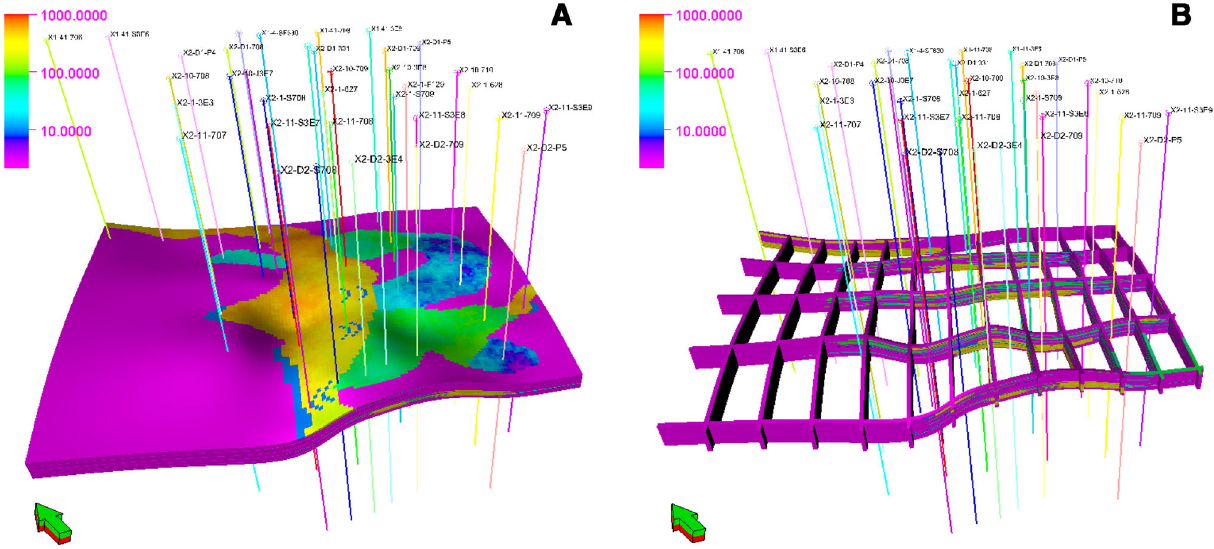
Fig. 10 Permeability models in the study area. a Permeability model of the S2 layer set in the study area; b permeability fence model of the S2 layer set in the study